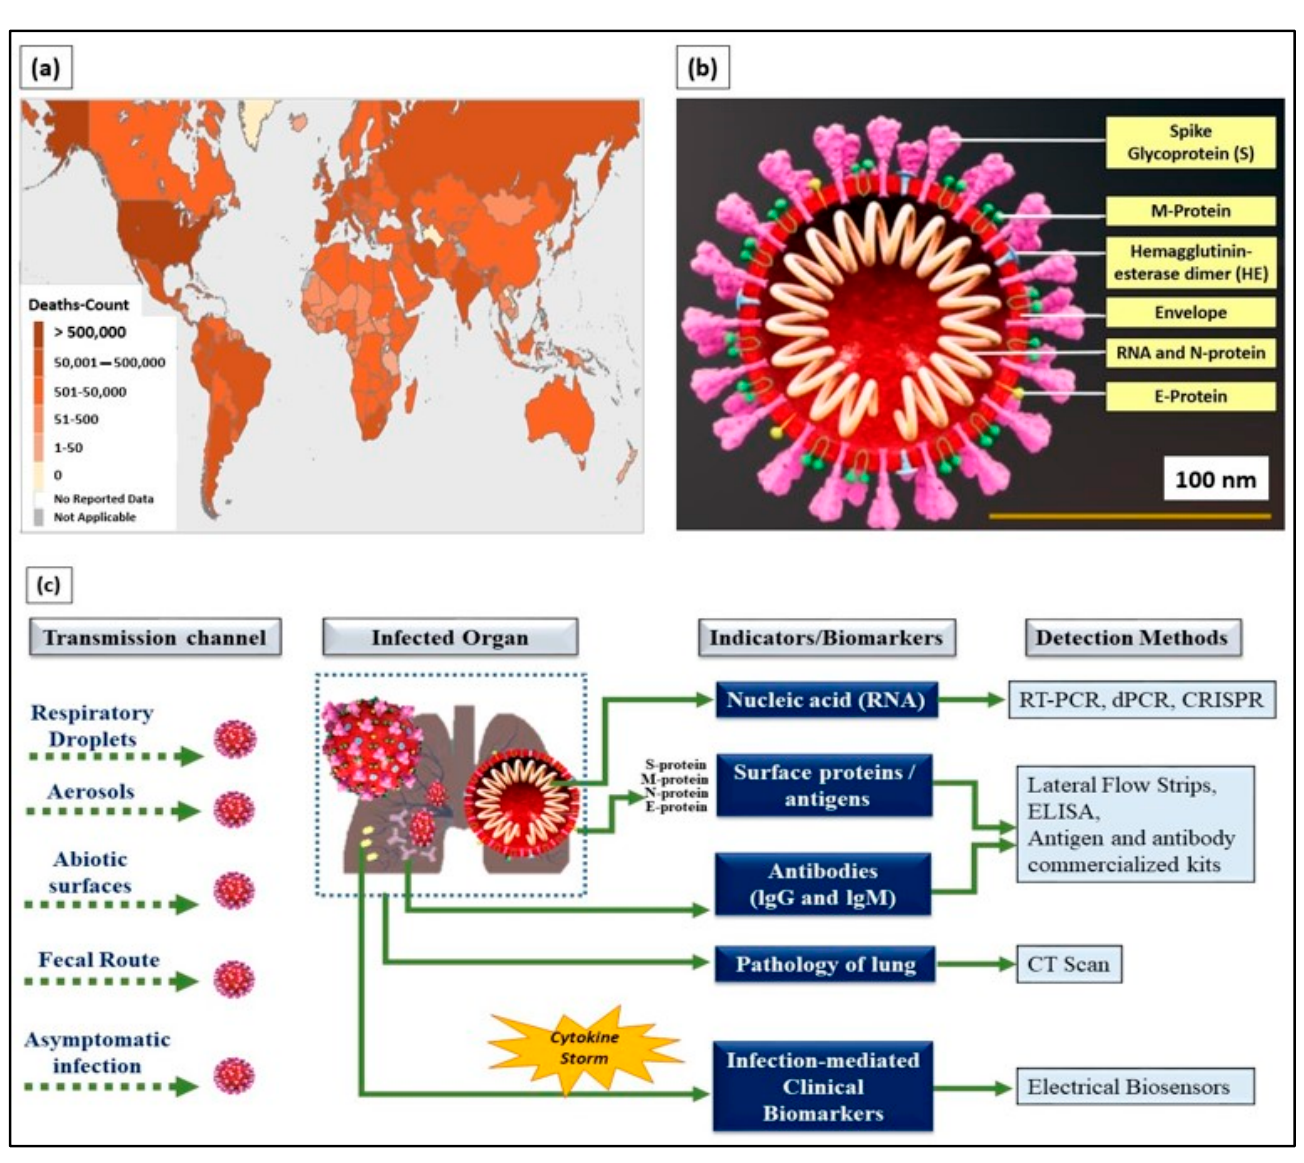
Figure 1. ( a ) World Health Organization (WHO) coronavirus disease 2019 (COVID-19) dashboard (choropleth map) indicating death count globally as of the 6th of May 2021 (4.43 pm CEST). ( b ) Cross-section of SARS-CoV-2 virus structure (picture credits: Scientific Animations/Wikimedia Commons). ( c ) Current existing indicators and biomarkers with transmission channels and detection methods are illustrated.